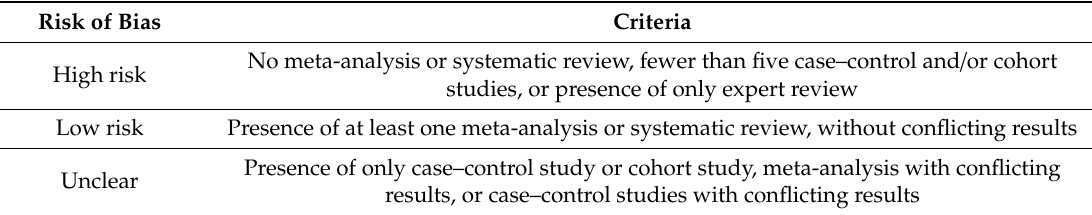
Table A2. Risk of bias was assessed according to the criteria of availability of meta-analysis or systematic review, study types, and with or without conflicting results, to judge evidence levels of high risk, low risk, or